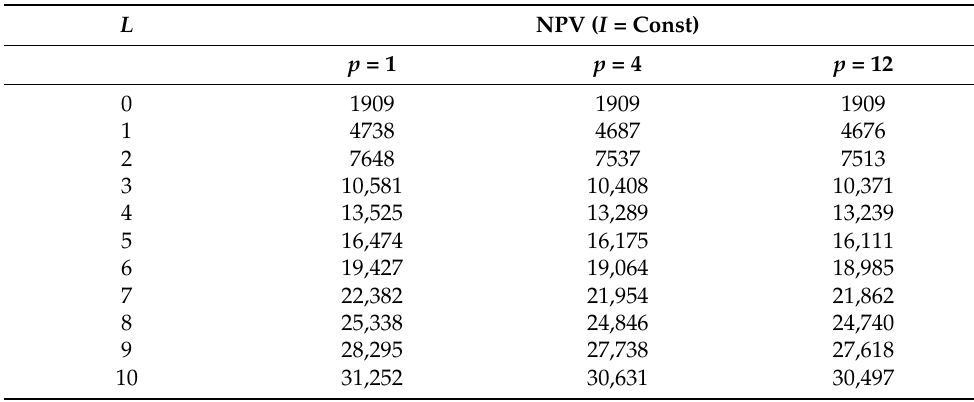
Table 4. Change of net present value, NPV, with leverage, L , for k d = 0.14, k 0 = 0.22, and p = 1, 4, and 12, for a perpetuity